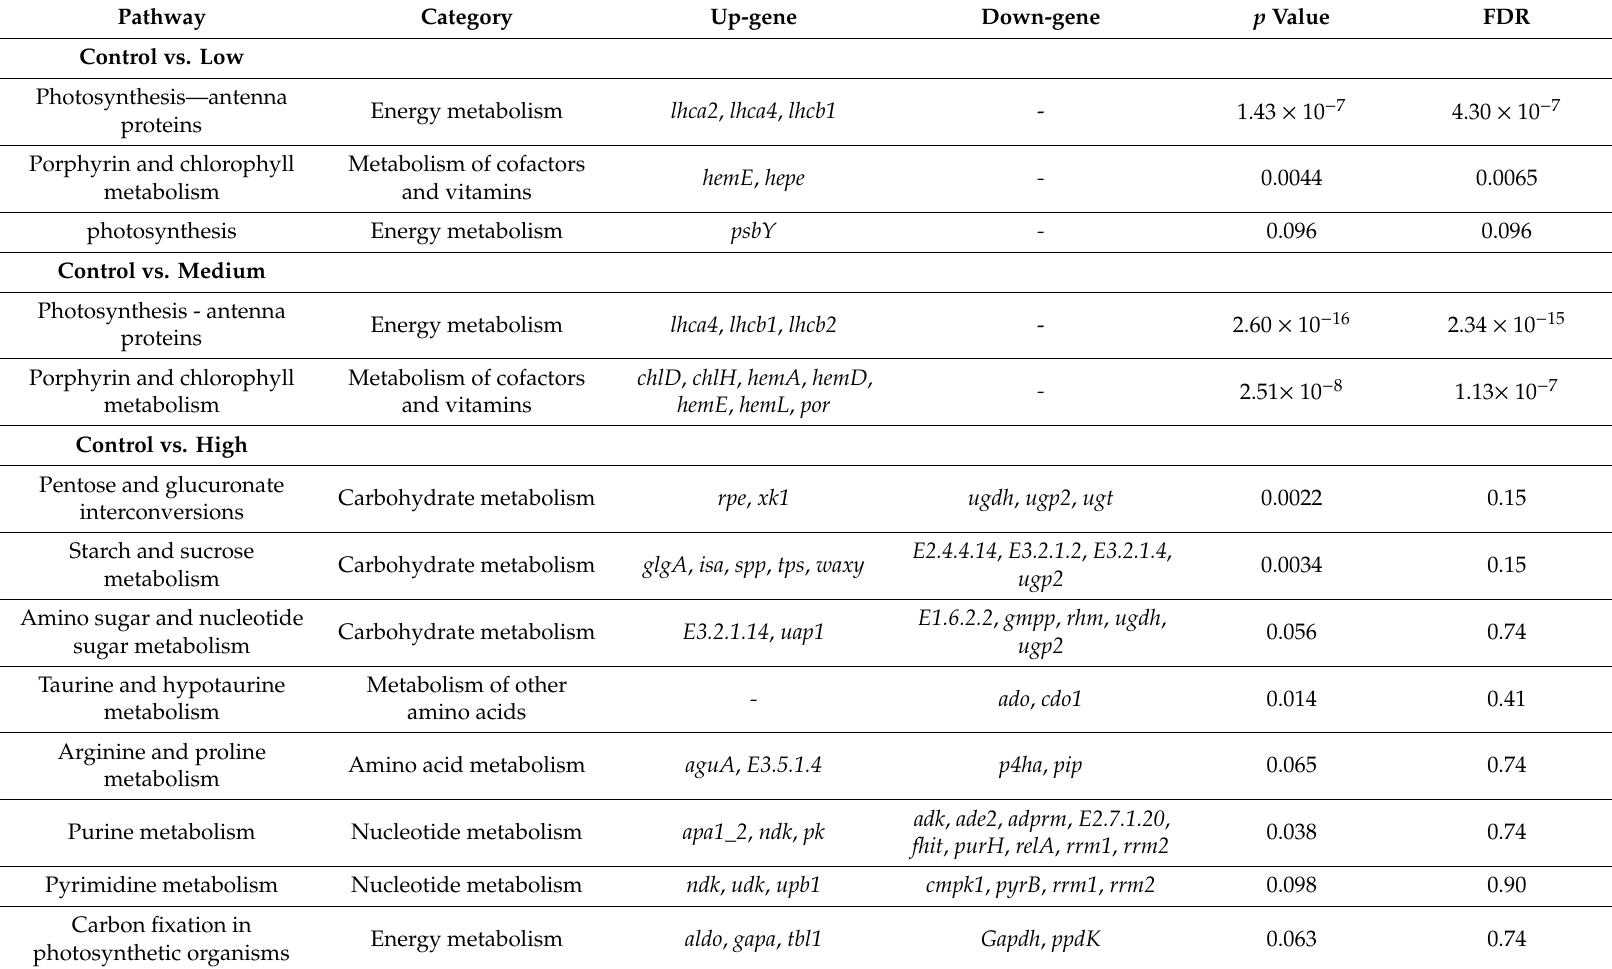
Table 1. List of main KEGG pathways changed by lincomycin treatment ( p <